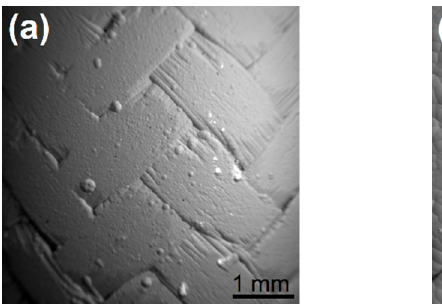
Figure 3. SiCf/SiC sample as received; three levels of surface roughness; ( a ) Ra ~ 50 μ m, ( b ) Ra ~ 10 μ m; ( c ) Ra ~ 1-3 μ m.